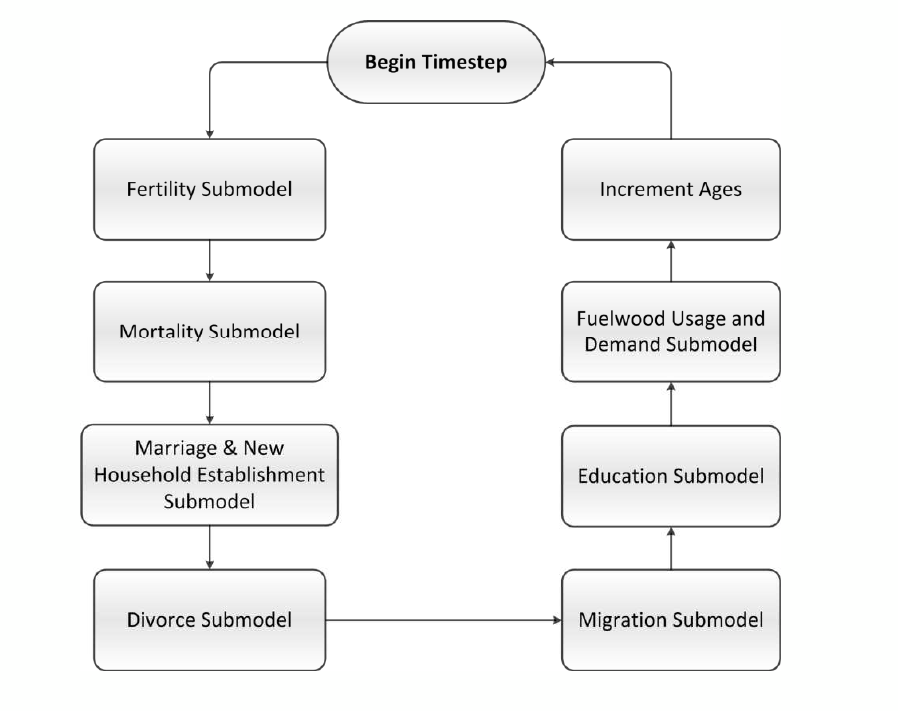
Figure A1.1: Process scheduling in the Chitwan